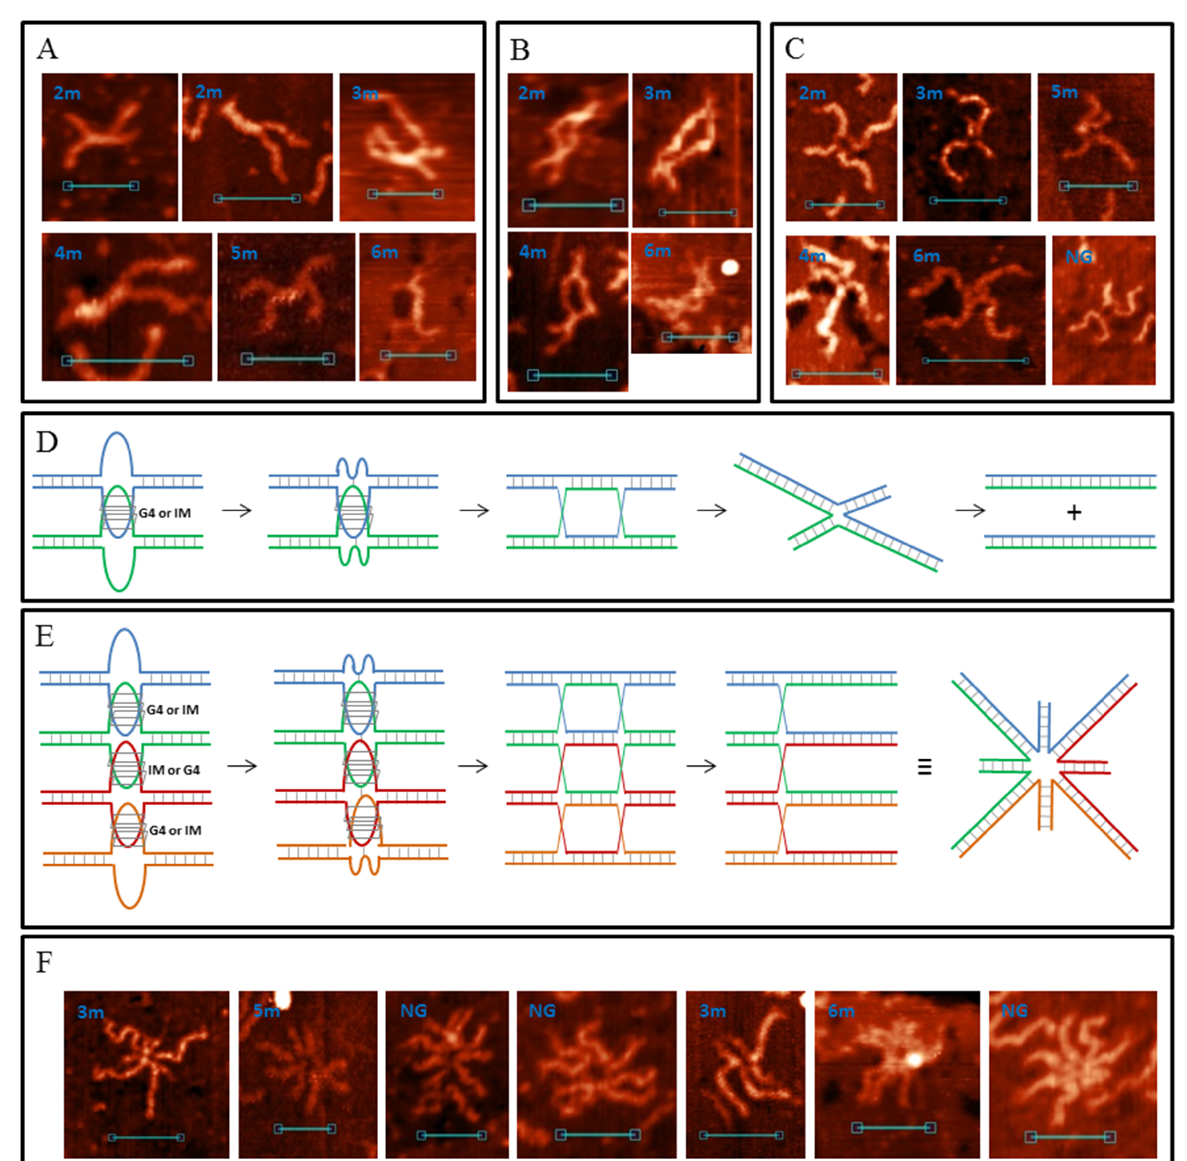
Figure 11. G4/IM-synaptic complex-promoted DNA strand exchange (recombination). ( A ) Examples of junctions with lengthy intersection points, revealed by AFM. ( B ) Structures with two HSs. ( C ) Junctions through one HS. Scale bars: 50 nm. ( D ) Schematic representation of the presumed mechanism of G4/IM-synaptic complex-promoted DNA strand exchange. ( E ) Presumed mechanism of tetra-HS formation from tetrameric G4/IM-synaptic complex. ( F ) Examples of multi-Holliday structures revealed by AFM. Scale bars: 50 nm.